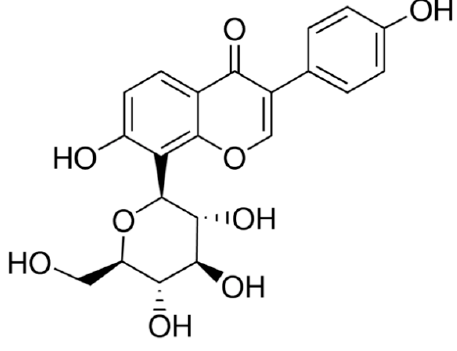
Figure 1. The chemical structure of puerarin.